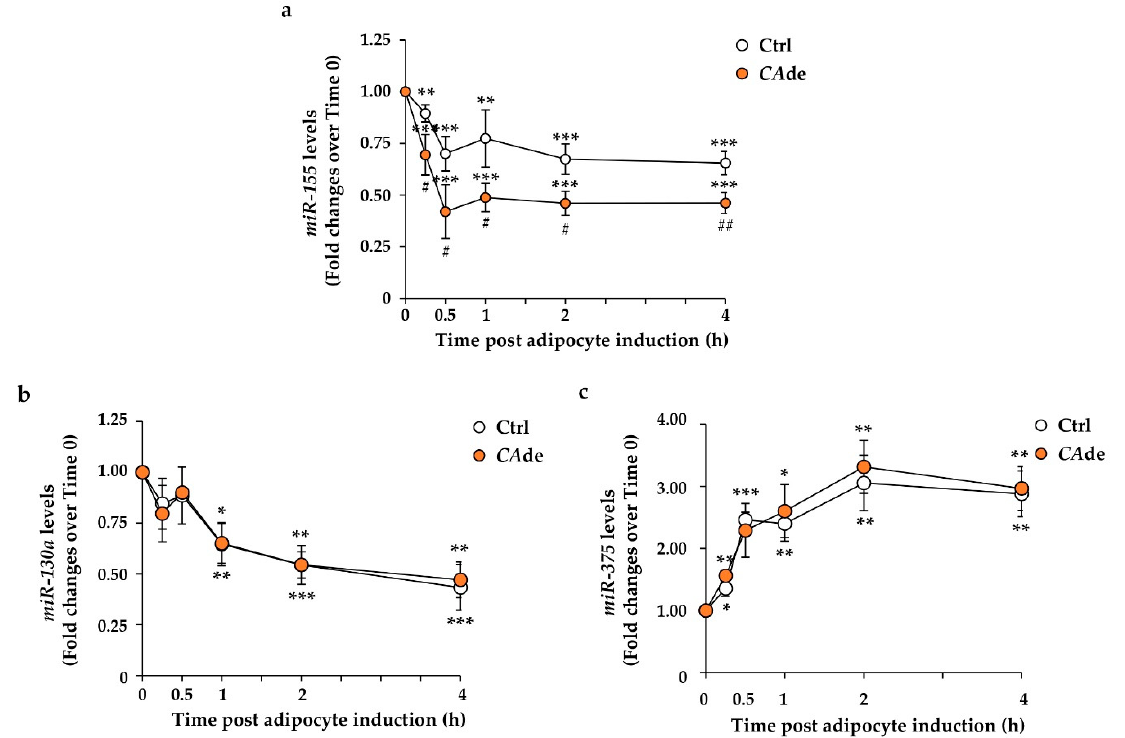
Figure 1. E ff ect of Citrus aurantium L. dry extracts ( CA de) on the expression of miR-155 during the early stage of adipogenesis in 3T3-L1 cells. 3T3-L1 pre-adipocytes were cultured for 0.25, 0.5, 1, 2, and 4 h with adipogenic di ff erentiation medium (AS) (Ctrl) or AS + CA de (100 µ g / mL). Time course of miR-155 ( a ), miR-130a ( b ), and miR-375 ( c ) levels, evaluated by quantitative real-time PCR, in Ctrl and CA de-treated cells relative to untreated 3T3-L1 cells at time 0. Values are means ± Standard Error of the Mean (SEM) of three independent experiments. Control value at time 0 was set as 1.00. Statistical significances among groups were tested by one-way ANOVA followed by Bonferroni correction post-hoc test (* p < 0.05, ** p < 0.01, and *** p < 0.001 vs. untreated 3T3-L1 cells at time 0; # p < 0.05, and ## p < 0.01 vs. control 3T3-L1 cells).